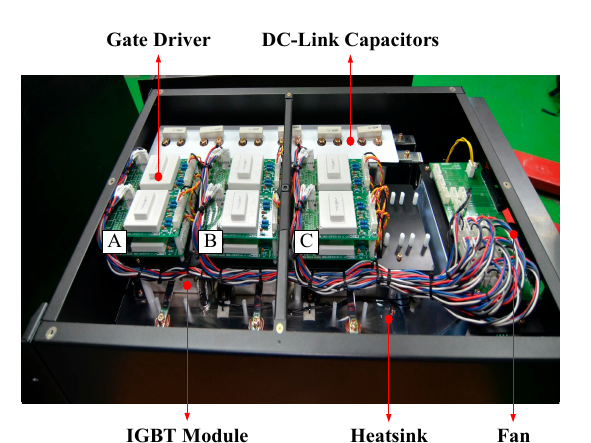
Figure 12. Experiment system of the three-level NPC active rectifier.